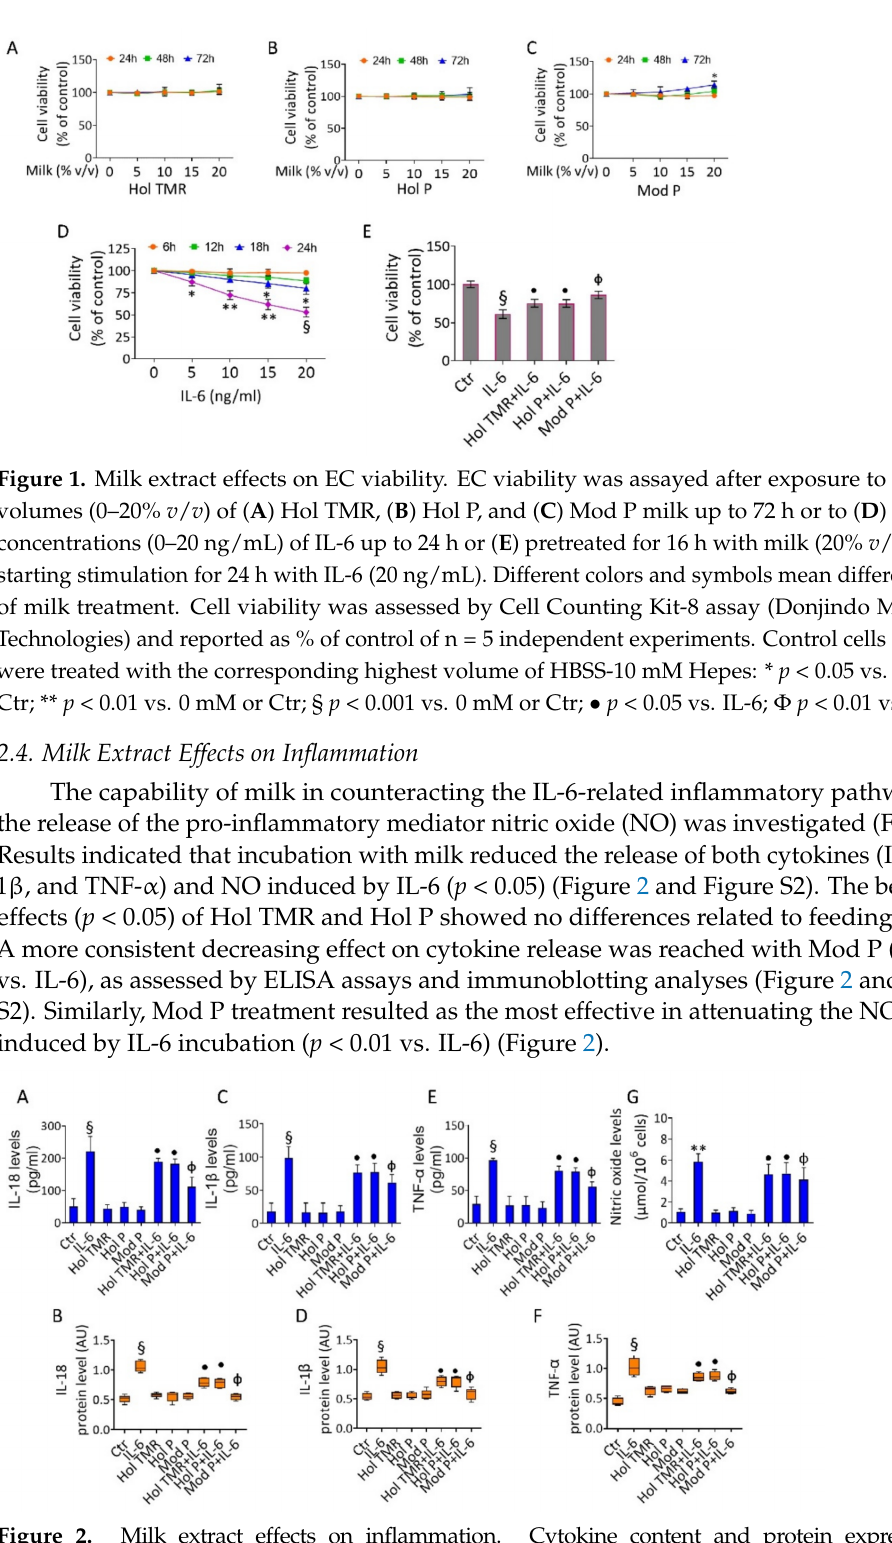
Figure 2. Milk extract effects on inflammation. Cytokine content and protein expression of ( A , B ) IL-18, ( C , D ) IL-1 β , and ( E , F ) TNF- α , detected by ELISA assay and Western blotting analysis. ( G ) Nitric oxide content evaluated in ECs treated with Hol TMR, Hol P, or Mod P milk (20% v / v ) for 72 h, IL-6 (20 ng/mL) for 24 h, or pretreated for 16 h with milk before stimulation for 24 h with IL-6. Control cells (Ctr) were treated with the corresponding highest volume of HBSS-10 mM Hepes. For immunoblotting, boxplots represent the densitometric mean values, expressed as arbitrary units (AU) of n = 5 independent experiments: ** p < 0.01 vs. Ctr; § p < 0.001 vs. Ctr; • p < 0.05 vs. IL-6; Φ p < 0.01 vs.